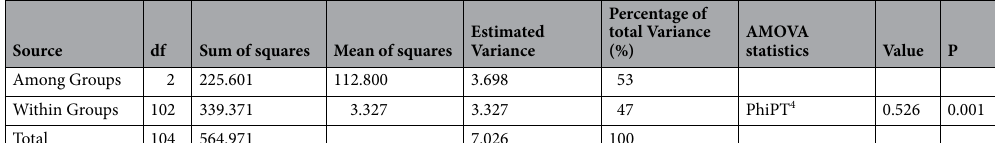
Percentage of total Variance Estimated Variance